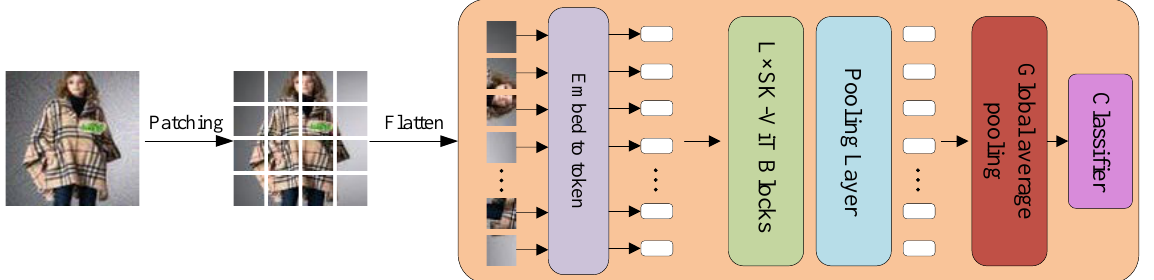
Figure 1. Network diagram of SK-ViT model.